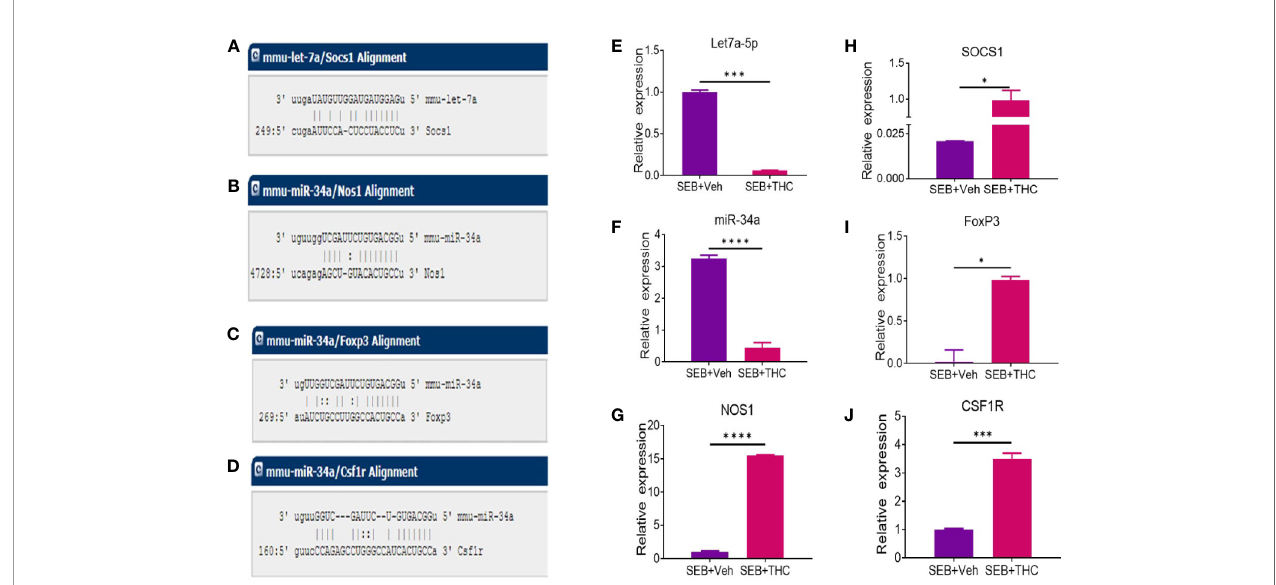
FIGURE 6 | Validation of selective miRs and targeted genes: Groups of fi ve mice were treated with SEB + Veh or SEB + THC as described in Figure 1 legend. MNCs from the lungs were isolated and screened for miR expression and in fl ammatory markers by quantitative RT-PCR. (A) Showing binding af fi nity between miR- let-7a-5p and SOCS1. (B – D) Showing binding af fi nity between miR-34a-5p and NOS1, FoxP3 and CSF1R. ( E , F ) Expression of miR-let-7a-5p and miR-34a-5p. (G – J) Expression of targeted genes NOS1, SOCS1, FoxP3 (I) , and CSF1R (J) in lung in fi ltrated MNCs. Gene expression in panels (E – G) was calculated as relative gene expression ( D C T ). Statistical signi fi cances are depicted as *p < 0.05, ***p < 0.001, ****p < 0.0001 between the compared